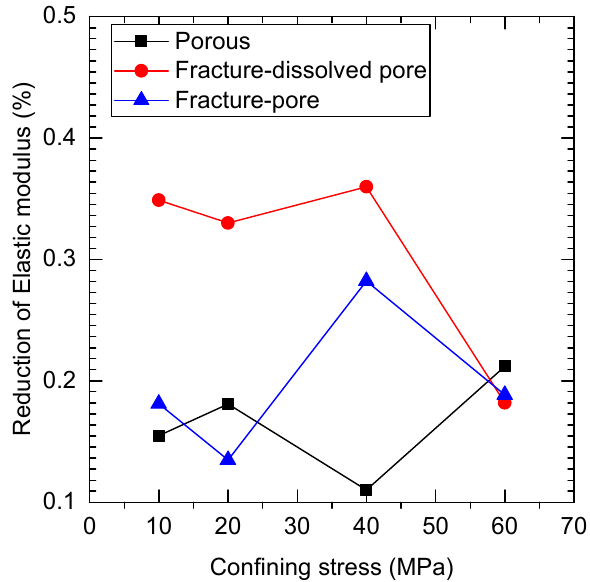
Figure 7. Elastic modulus reduction of rock samples with different reservoir space.